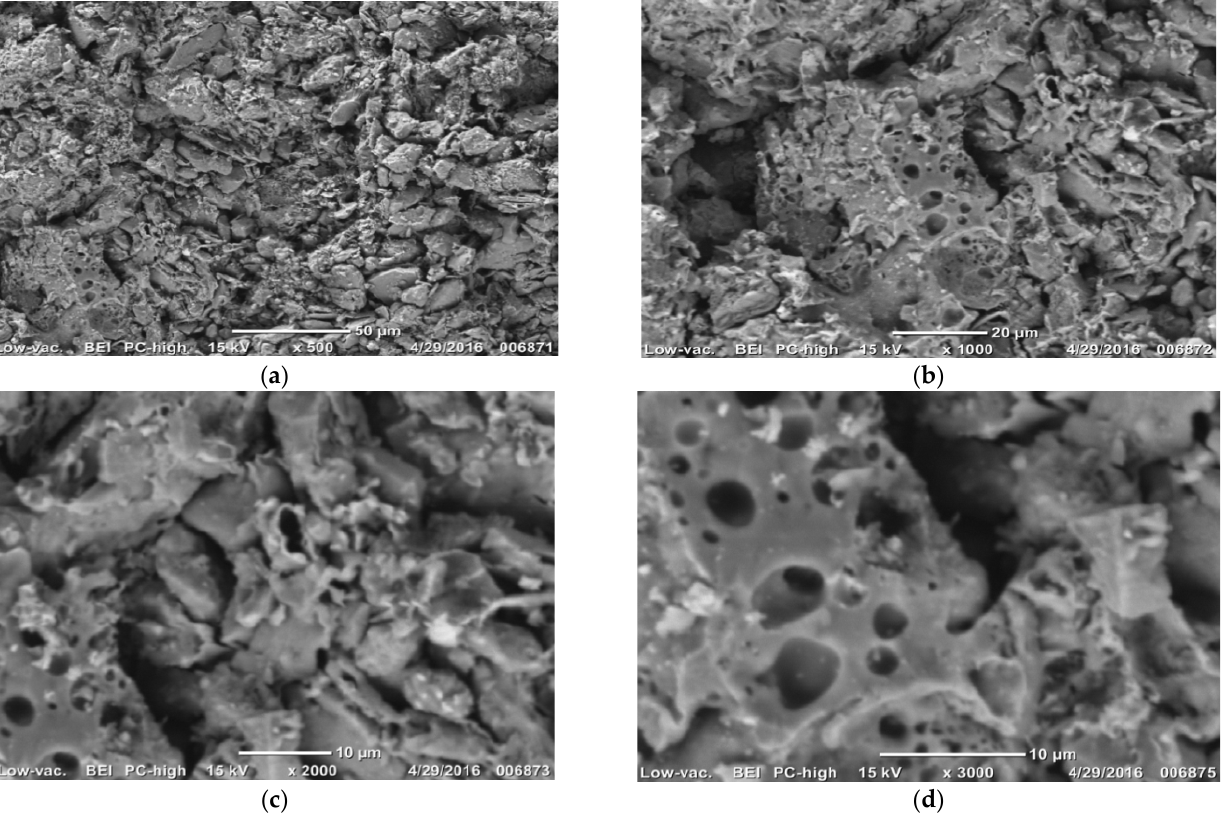
Figure 10. Microstructure of the fired ceramic sample with the addition of 25% spent sorbent. Magnification: ( a ) ×500, ( b ) ×1000, ( c ) ×2000, ( d ) ×3000.